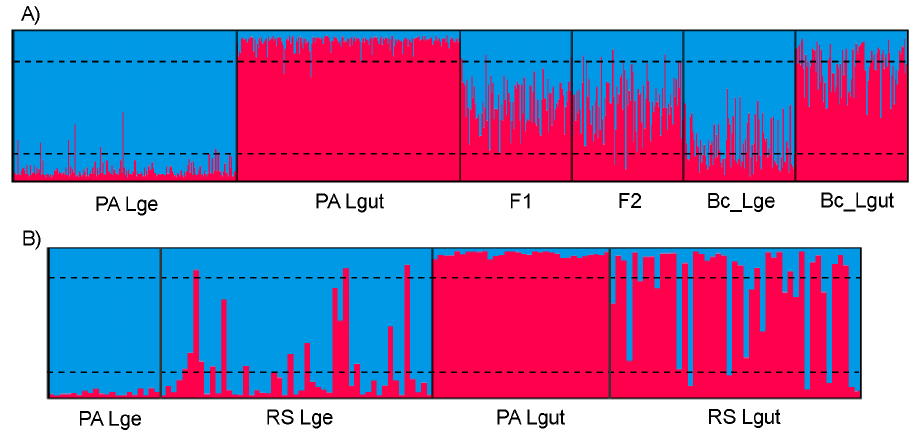
Figure 3. Bar plotting of the results obtained with STRUCTURE using K=2. Each individual is represented by a vertical bar, with the colors indicating the proportion of its genomic membership in ( i.e. assignment to) the two clusters: L. geoffroyi (blue) and L. guttulus (red). A) Simulated genotypes belonging to Leopardus geoffroyi and L. guttulus parental groups (PA Lge and PA Lgut), and the four hybrid categories: F1, F2, backcross with L. geoffroyi (Bc_Lge) and backcross with L. guttulus (Bc_Lgut). B) Real data from parental/control L. geoffroyi and L. guttulus (PA Lge and PA Lgut, respectively) and hybridizing populations from Rio Grande do Sul state (RS Lge and RS Lgut). The two horizontal dashed lines indicate the threshold of 0.8 assignment to each cluster.